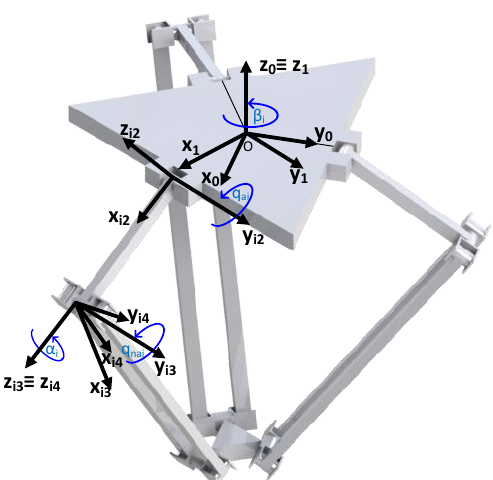
Figure 5. The Delta’s coordinate reference systems